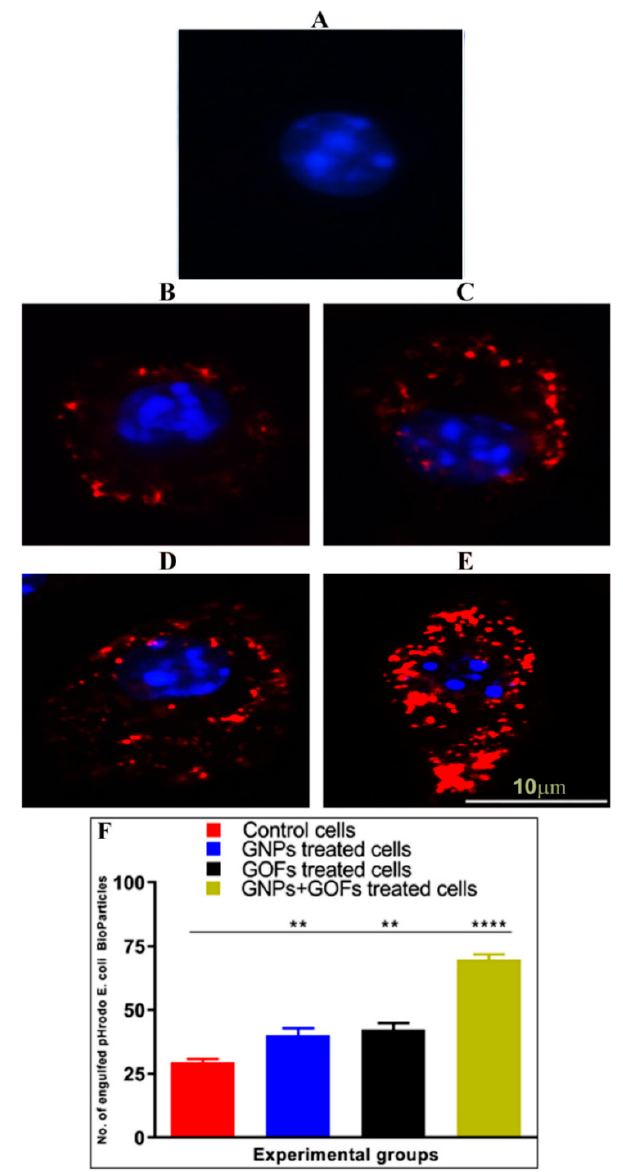
Figure 6. GNPs and GOFs enhanced phagocytosis of pHrodo E. coli BioParticles . ( A ) Control, untreated BMDMs cells stained with DAPI (blue). ( B ) Cells treated with pHrodo E. coli BioParticles (red) alone. ( C ) GNP-pretreated cells at a concentration of 10 µg/mL then treated with pHrodo E. coli BioParticles. ( D ) GOF-pretreated cells at a concentration of 10 µg/mL then treated with pHrodo E. coli BioParticles . ( E ) GNP- and GOF-pretreated cells at a 10 µg/mL concentration each then treated with pHrodo E. coli BioParticles . ( F ) The graph represents the number of engulfed of pHrodo E. coli BioParticles . Cells were quantified in 10 fields using Image J software version 1.43 (U.S. National Institutes of Health, Bethesda, MD, USA). Data are represented as mean ± SE. Statistical significance by one-way ANOVA ( p < 0.0001) followed by posthoc testing using Tukey’s multi group comparison with control cells: ** p < 0.01, **** p < 0.0001 indicate statistically different from control